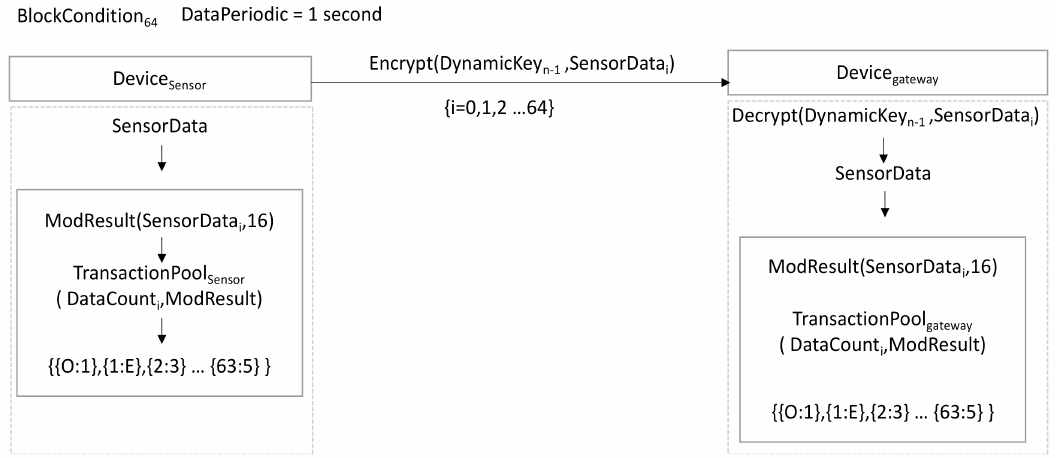
Figure 7. Transaction pools stored by sensor device and gateway